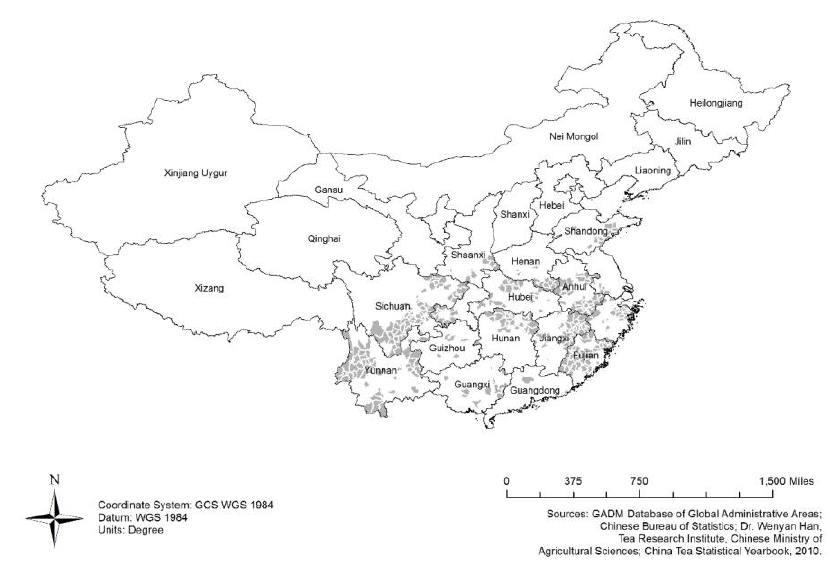
Figure 2. Map of China’s major tea producing counties. Counties within each province where tea production has traditionally occurred or where tea is currently produced are shaded in grey. Table 1. Description of weather